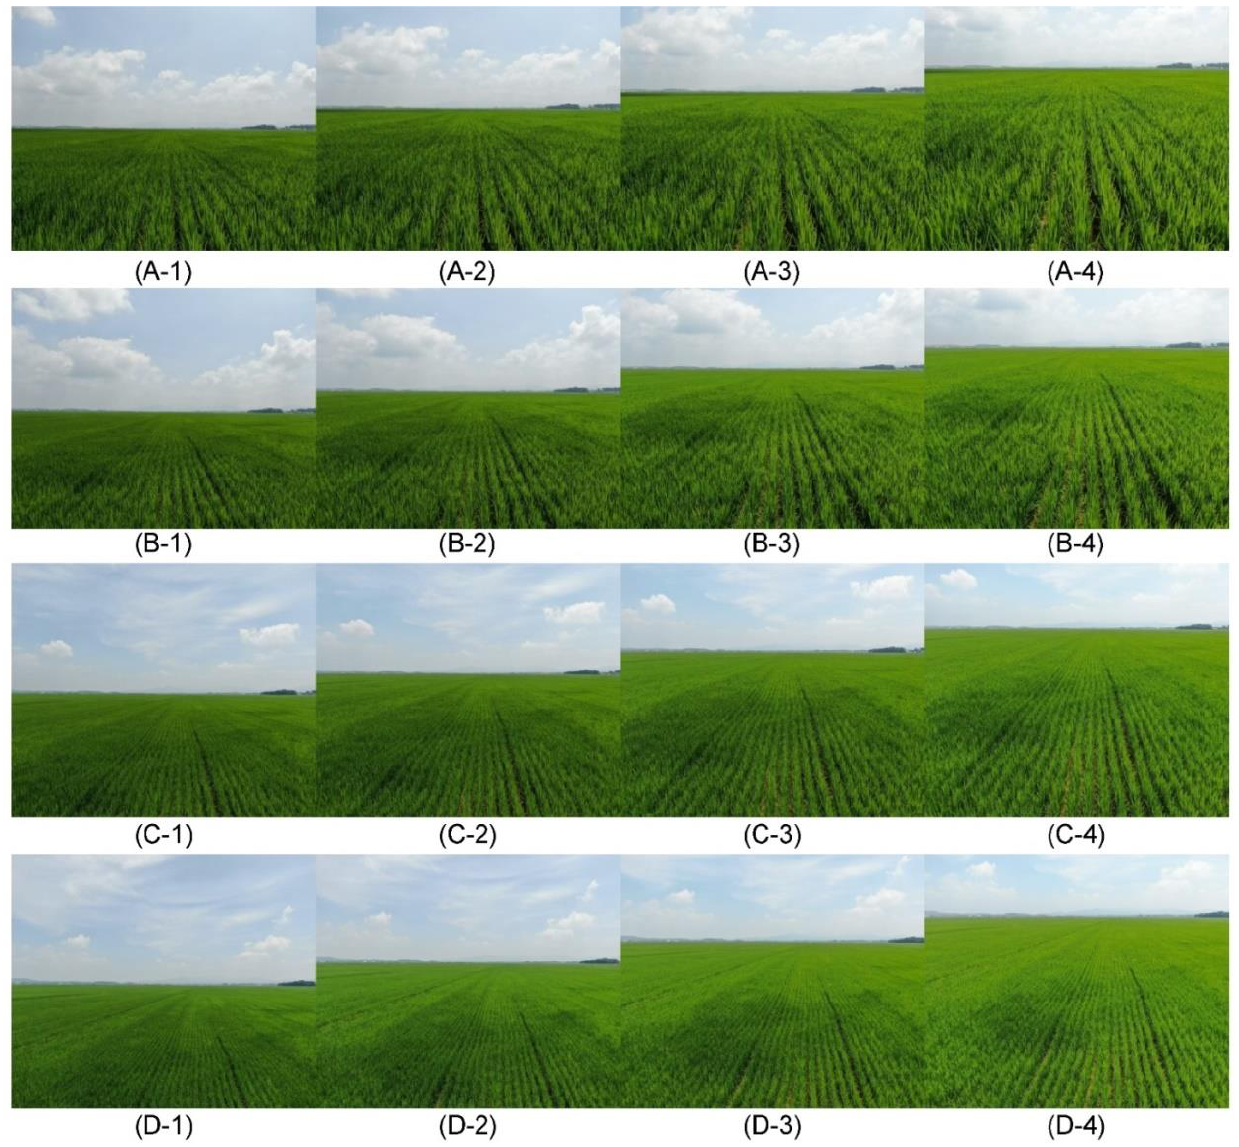
Figure 12. Drone images collected from various height and angles conditions ( A – D ) heights of 1, 2, 3, and 4 m, respectively; ( 1 – 4 ) 0°, 10°, 20°, and 30° down angles, respectively. In the experiment, the same location RBD-infected bunch sample was labeled across all conditions. Since there few samples existed in the same location, 91 matched data were obtained for each height and angle condition. Similarly, normal bunches with the same location were also collected around 91 infected bunches under 16 conditions. Accordingly, 1456 normal bunches of data for 16 conditions, and 1456 RBD-infected bunch data were used in the